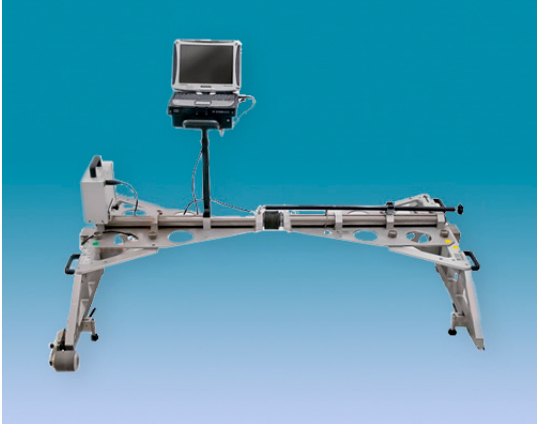
Table 1. AMBER measurement specifications. Figure 2. RMF-1100 [40]. Figure 2. RMF-1100 [40].